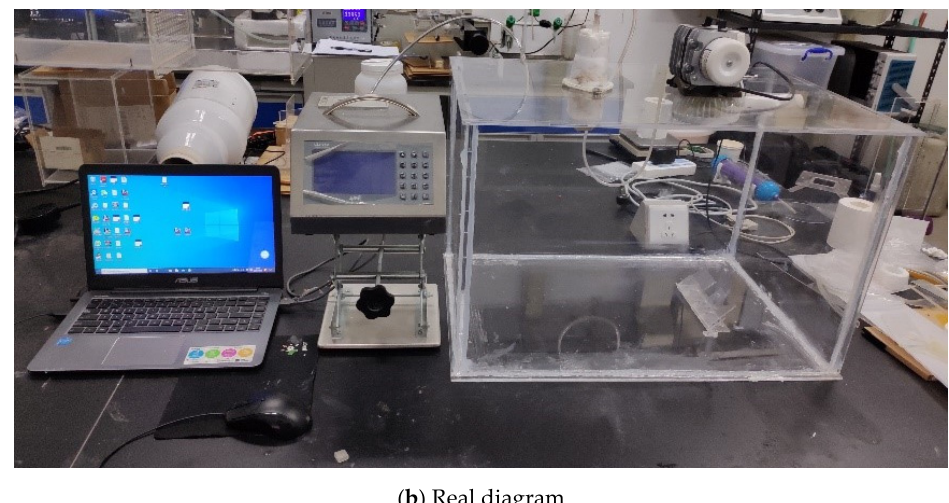
Figure 1. Experimental schematic of dust deposition on solar cell covering glass.